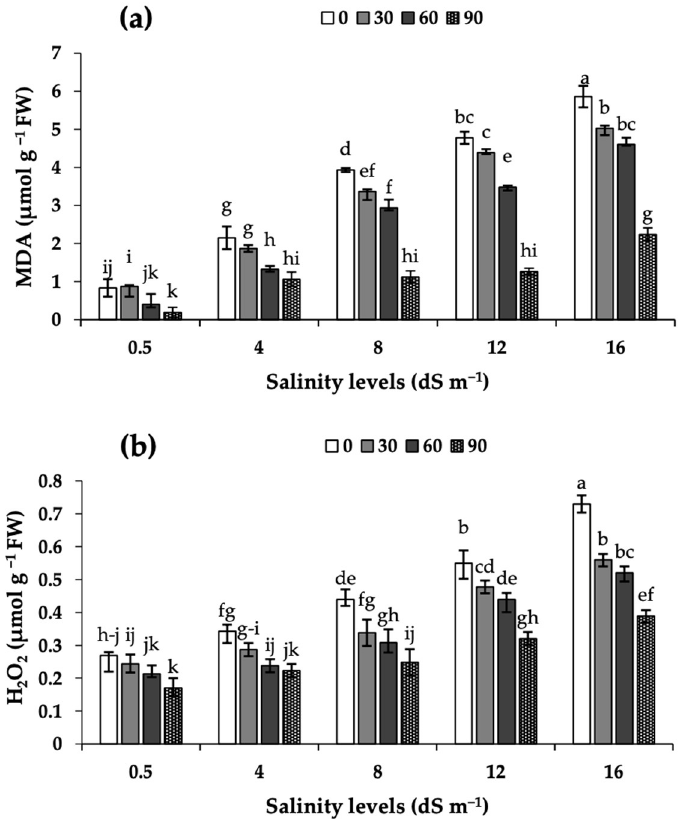
Figure 2. Effects of MEL foliar applications (0, 30, 60 and 90 µM) on MDA ( a ), and H 2 O 2 levels ( b ) in leaves of camelina grown under different levels of salinity (0.5, 4, 8, 12, and 16 dS m −1 ). MDA: malonyldialdehyde, and H 2 O 2 : hydrogen peroxide. Data shown are means of three replicates per treatment ± SD. Different letters above the columns indicate statistically significant differences at p < 0.05. Table 2. Effects of MEL foliar applications (0, 30, 60 and 90 µ M) on the shoot and root K and Na concentrations, translocation and selective transport in camelina grown under different levels of salinity (0.5, 4, 8, 12 and 16 dS m − 1